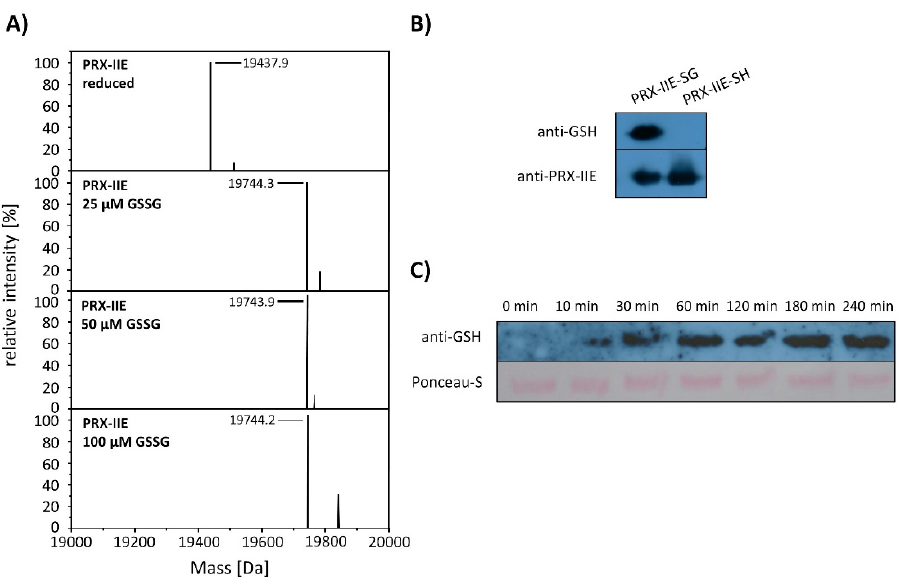
Figure 6. S-glutathionylation of PRX-IIE. ( A ) Deconvoluted mass spectra of reduced and S-glutathionylated PRX-IIE after treatment with oxidized glutathione (GSSG). Reduced PRX-IIE (19,438 Da) was treated with indicated GSSG concentrations and the degree of modification was estimated from the mass shift of 306 Da to 19,744 Da, which could be assigned to monoglutathionylated protein. Data are representative spectra of n = 12, with protein from three independent protein purifications. ( B ) Western blot analyses of reduced and S-glutathionylated PRX-IIE (treatment with 10 mM GSSG) using specific anti-GSH and anti-PRX-IIE antibody. ( C ) Time dependence of S-glutathionylation with recombinant PRX-IIE in vitro.